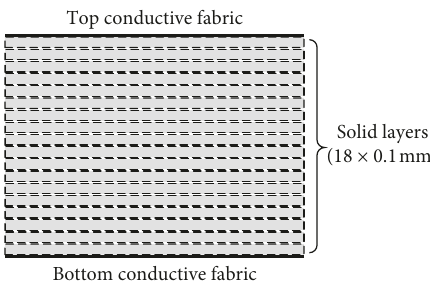
Figure 3: 3D printed NinjaFlex substrate: stack of printed